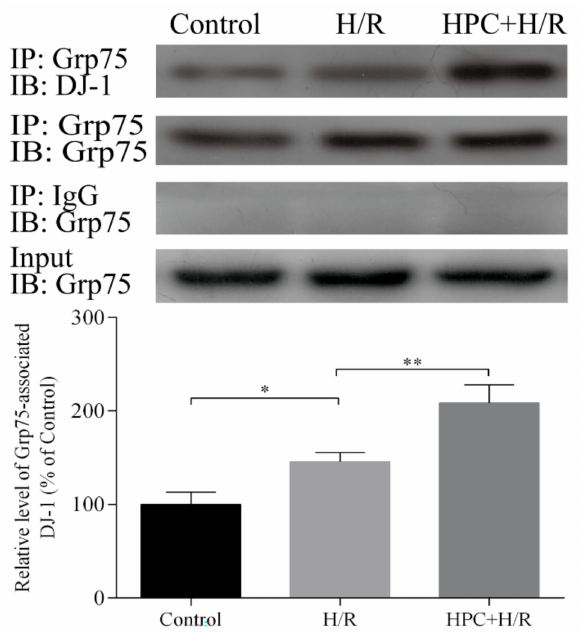
Figure 1. E ff ect of hypoxic preconditioning (HPC) on the interaction of DJ-1 and Grp75 in H9c2 cells subjected to hypoxia / reoxygenation (H / R). HPC was induced 24 h prior to H / R in H9c2 cells, and the interaction of DJ-1 and Grp75 was assessed by co-immunoprecipitation. Cell lysates were immunoprecipitated (IP) with IgG or anti-Grp75 antibody and immunoblot (IB) analysis was performed with anti-DJ-1 or anti-Grp75. Total protein extracts (prior to IP) were used as control (Input) and IgG-precipitated template served as specificity control. Representative blots from three independent experiments and bar graphs from their densitometric analyses are shown. The data are presented as mean ± SD. * p < 0.05, ** p < 0.01 as indicated on the